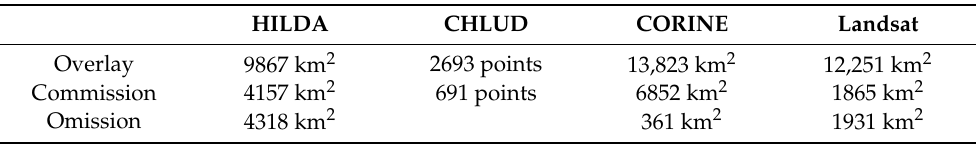
Figure 2. Cropland area reported by analysed land use/land cover data sources. Table 2. Comparison of cropland area derived from the analysed datasets with the reference data from Land Paracel Identification System.